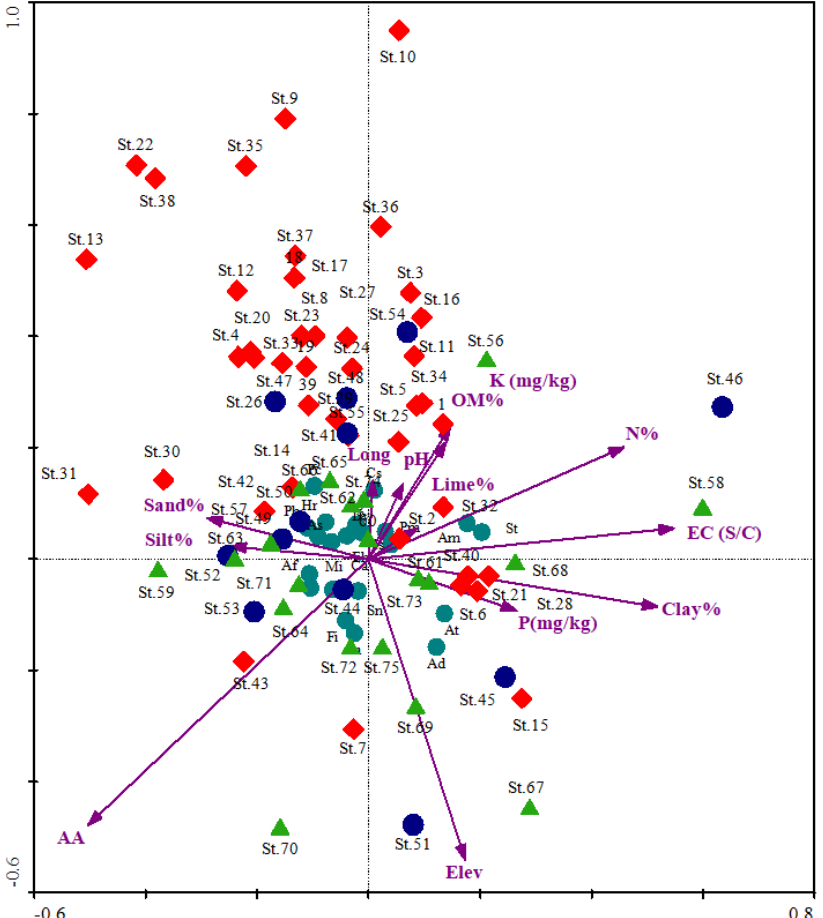
Figure 5. Canonical correspondence analysis biplot showing the relation of vegetation and related environmental and soil variables. The correlation and biplot scores revealed the same loading of axis 1 with higher correlation scores for the environmental variables. The soil textural parameters were found to have a high correlation, i.e., r = 0.91, 0.77, and − 0.52 for clay, silt, and sand per- centages, respectively, on axis 1. In nutrient organic matter, lime, nitrogen, potassium, and phosphorus were found to have a significant negative correlation on axis 1, whereas ni- trogen and organic matter have a significant positive correlation on axis 2 (Table 5).